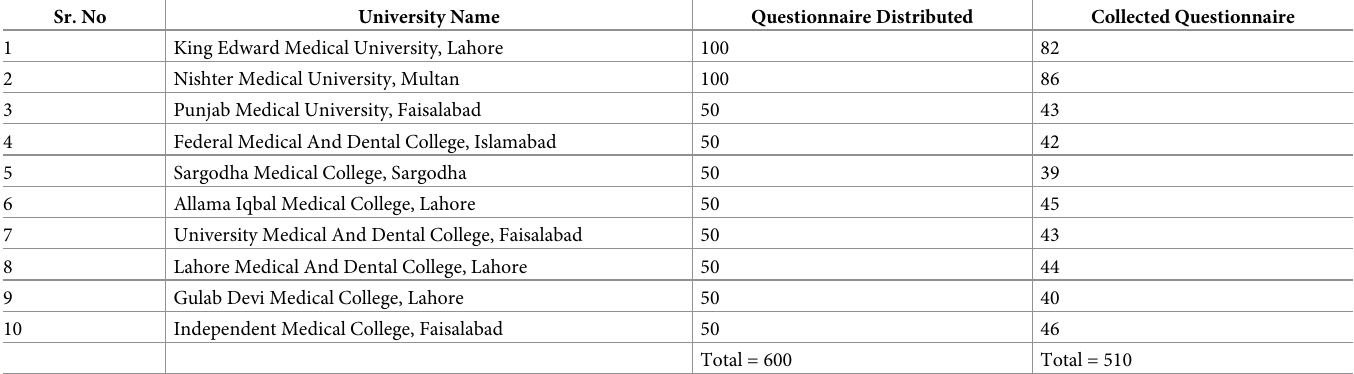
Table 1. List of medical